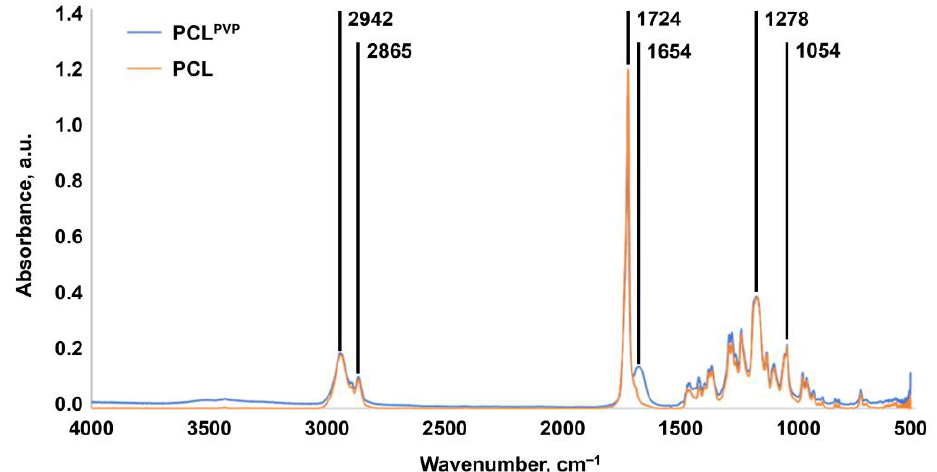
Figure 2. Fourier-transform infrared spectroscopy of unmodified and PVP-coated TEVGs. Note C=O stretching bands at 1724 cm −1 , C‒O stretching bands at 1278 and 1054 cm − 1 , asymmetric vibrations in the CH 2 ‒ group at 2942 cm −1 , symmetric vibrations in the CH 3 – group at 2865 cm −1 , and ‒CONH 2 group within the pyrrolidone ring at 1654 cm −1 . The latter functional group is unique for PVP-coated TEVGs.